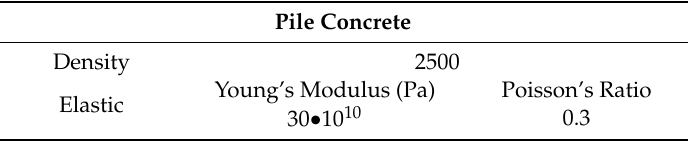
Table 2. The characteristic of Pile